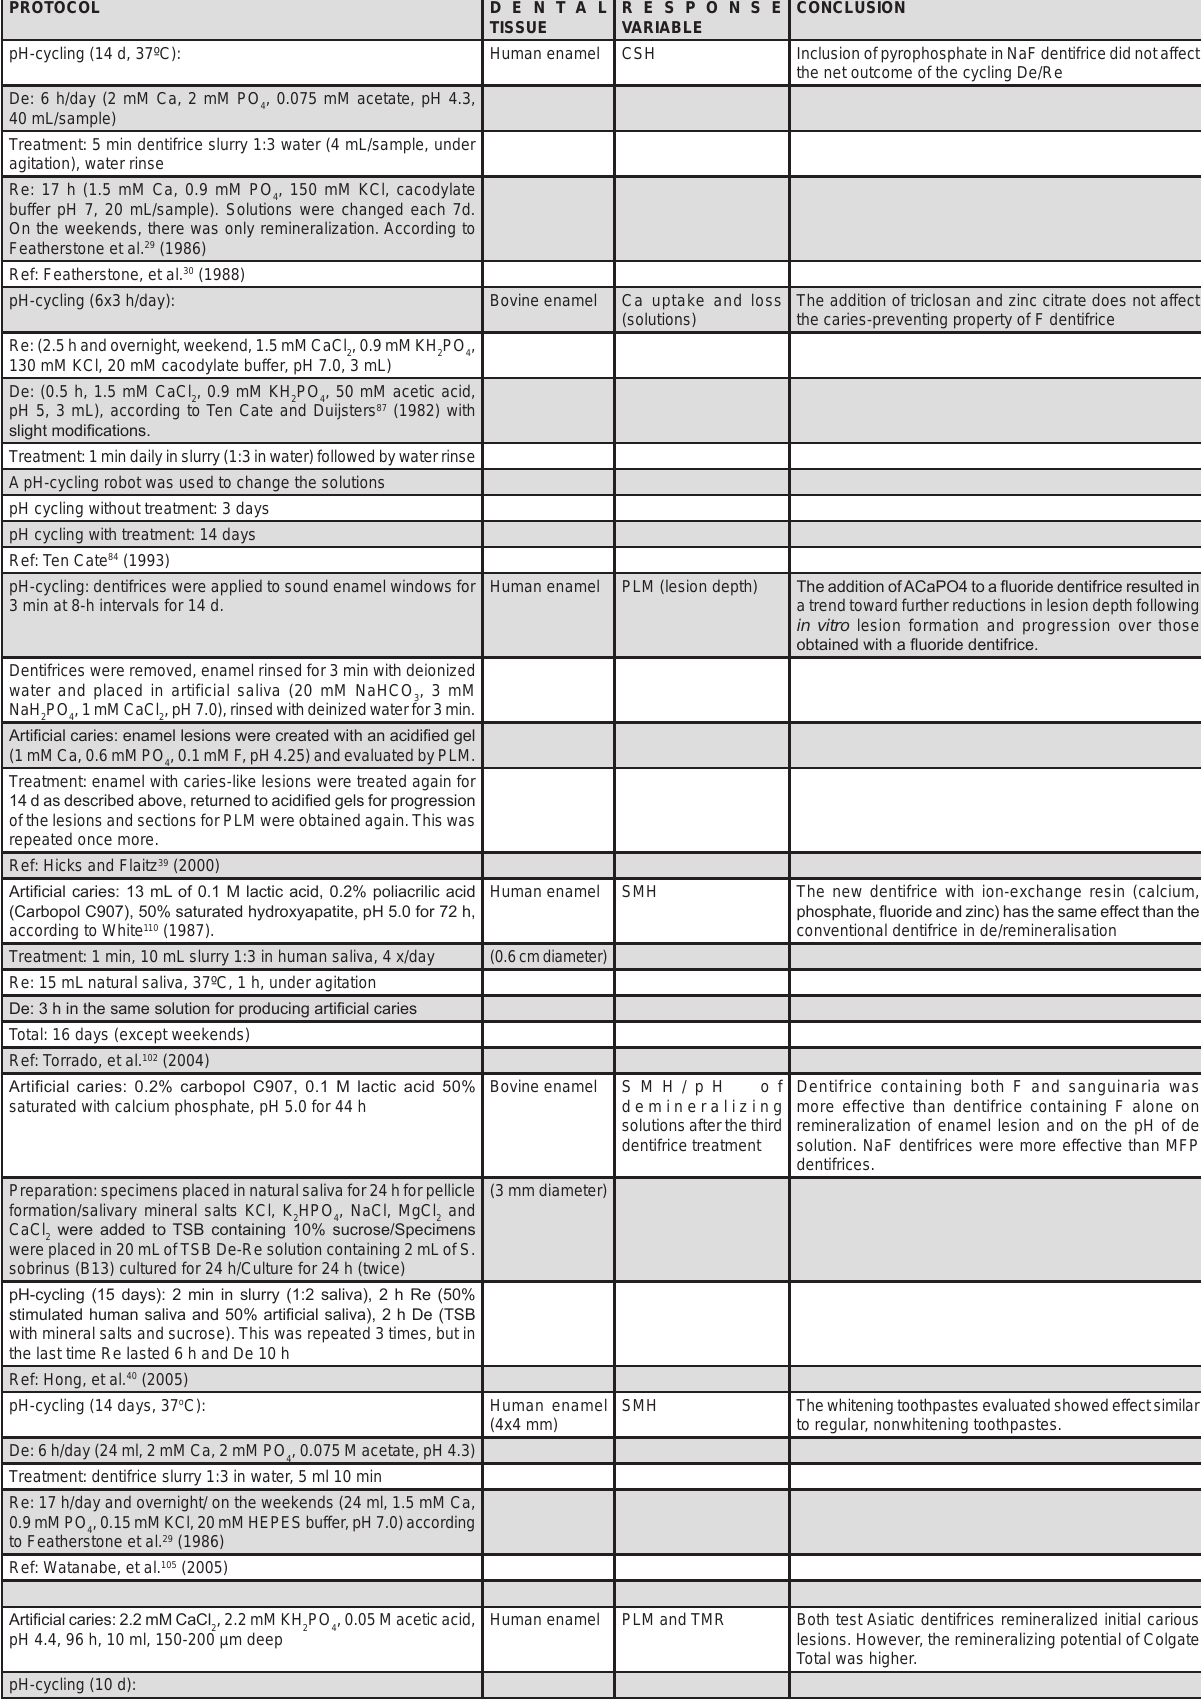
Human enamel PLM and